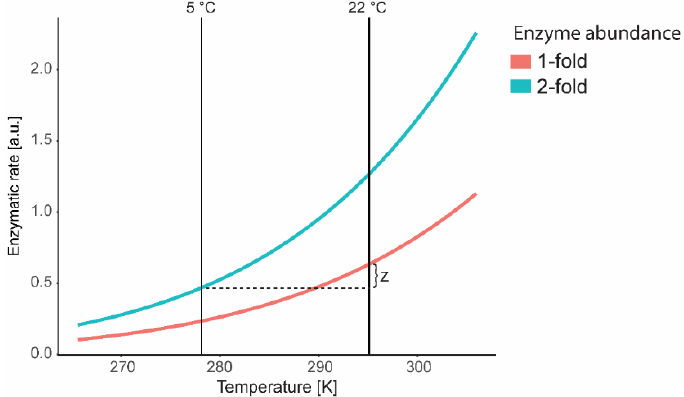
Figure 1. Enzymatic rates with single (1-fold, red, 22 °C) and doubled (2-fold, blue, 5 °C) enzyme abundance. The adjusted v max enzyme activity with doubled abundance at 5 °C is lower than the adjusted activity at 22 °C (factor: z). Enzymatic rates were calculated using the Arrhenius equation (Equation 1).